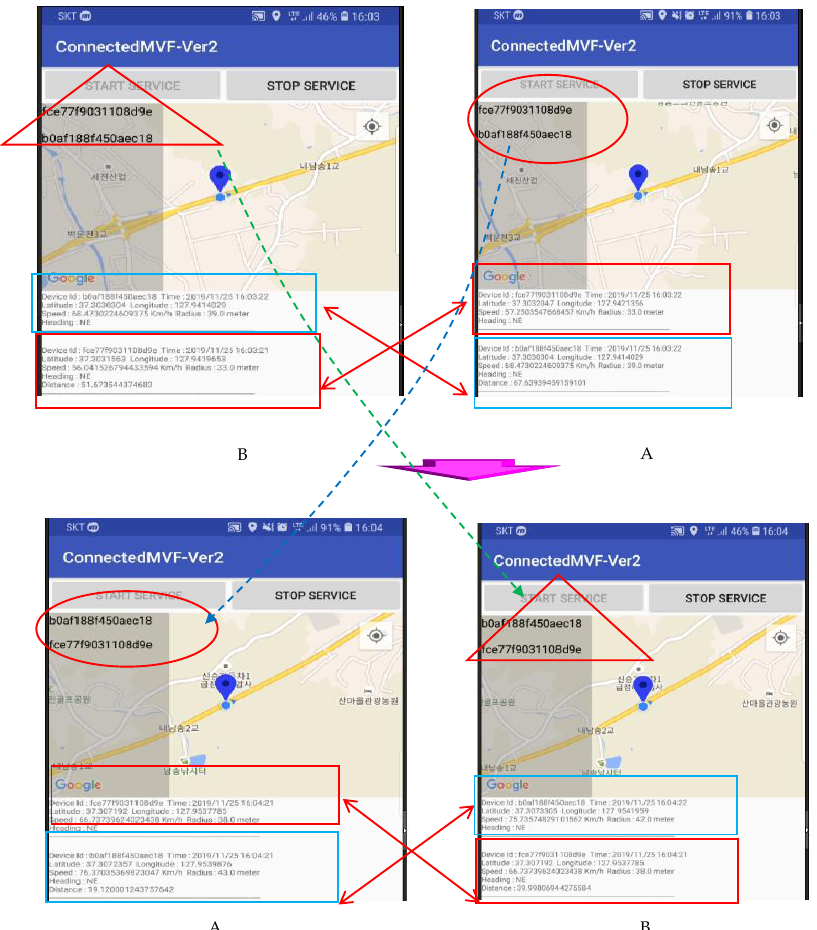
Figure 5. Screen images showing when a connected group is formed and when overtaking occurs.